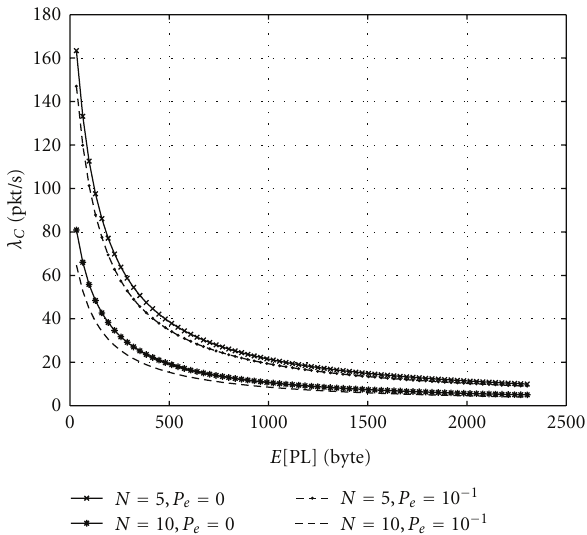
e as noticed in the